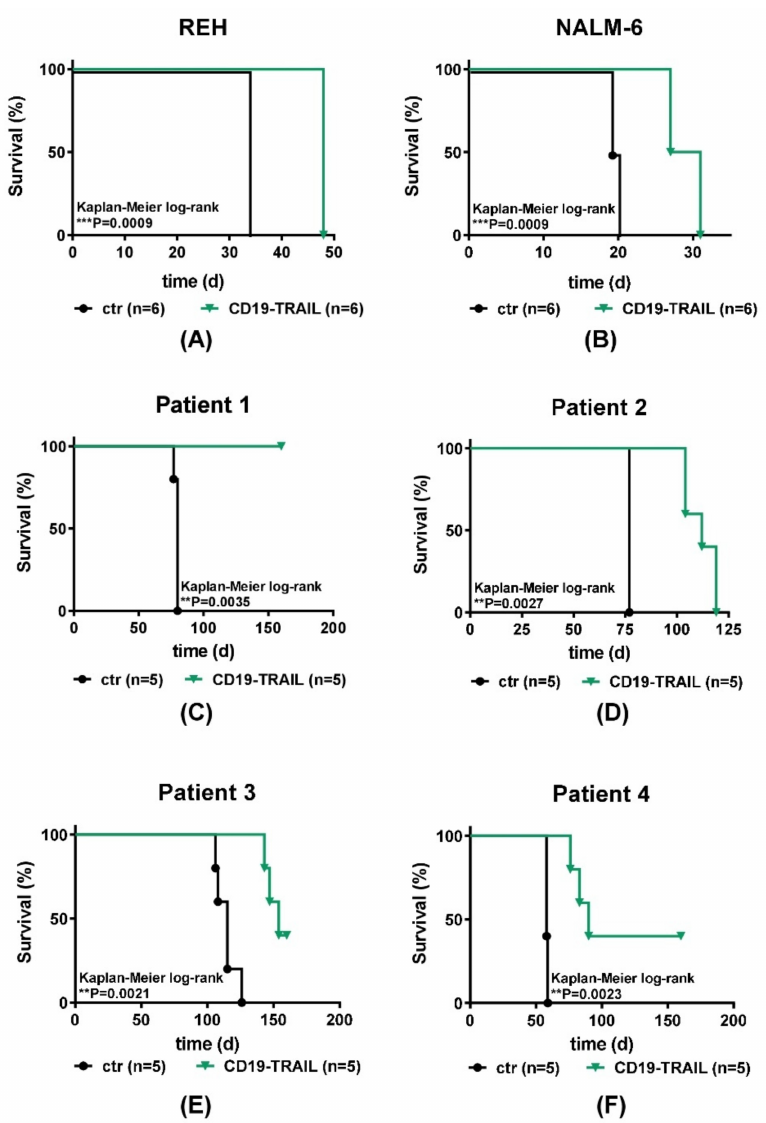
Figure 4. CD19-TRAIL eradicates BCP-ALL cells in vivo. Survival of female NSG-mice intravenously injected with ( A ) 0.5 × 10 6 REH ( n = 6 per group); ( B ) 0.5 × 10 6 NALM-6 ( n = 6 per group); or ( C – F ) 1 × 10 5 patient-derived ALL xenograft (PDX; n = 5 per group) cells (day 0). On days +1, +3, +6, +10, +13 and every 7 days thereafter, mice were treated with 1.5 mg/kg of CD19-TRAIL intravenously or left untreated (ctr). At signs of overt leukemia (detection of >75% leukemic blasts in the peripheral blood or clinical signs of leukemia including loss of weight or activity, organomegaly, hind-limb paralysis), mice were euthanized. Differences in survival were calculated using Kaplan–Meier log-rank test, ** p < 0.01, *** p <